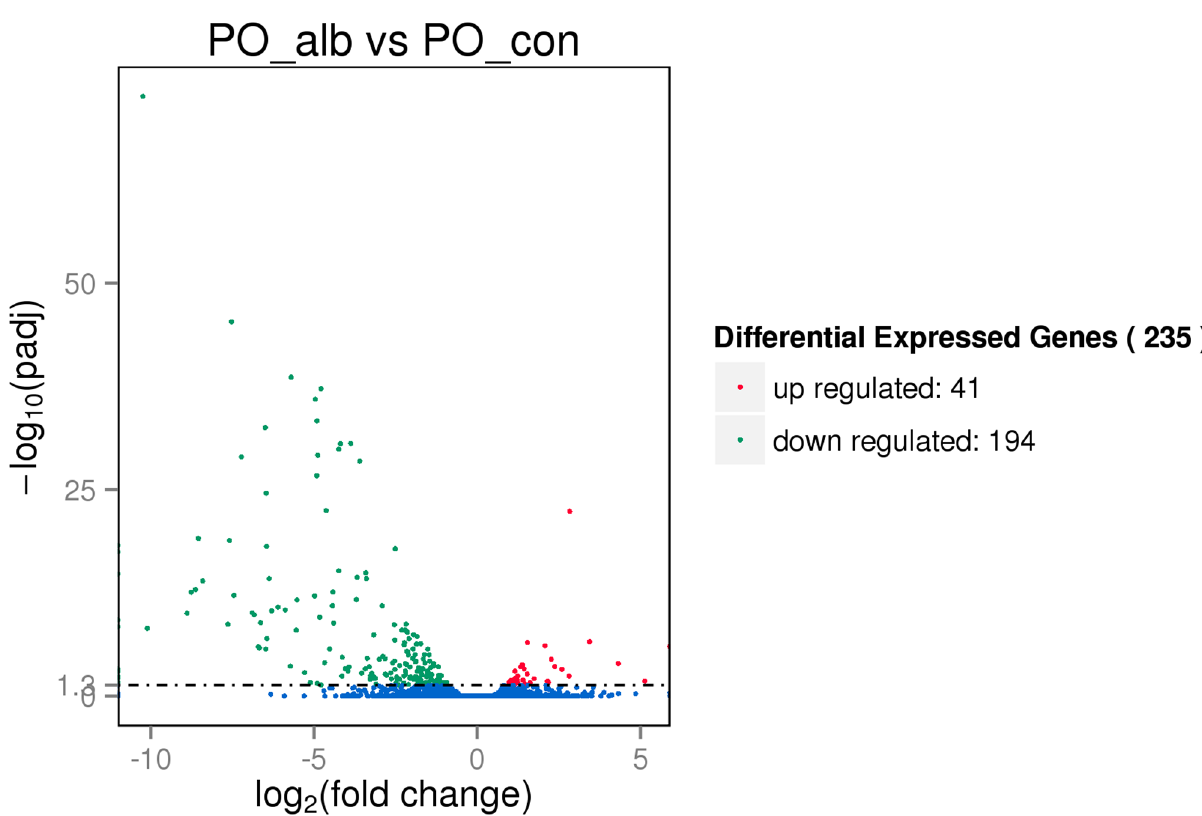
Fig 1. The volcanoplot of differentially expressedgenes in RNA-seq. The differentially expressedgenes including 41 up-regulated genes and 194 down-regulatedgenesin PO_alb vs PO_con were illustratedin a volcanoplot (fold change (cid:21) 2and q-value (cid:20) 0.05).